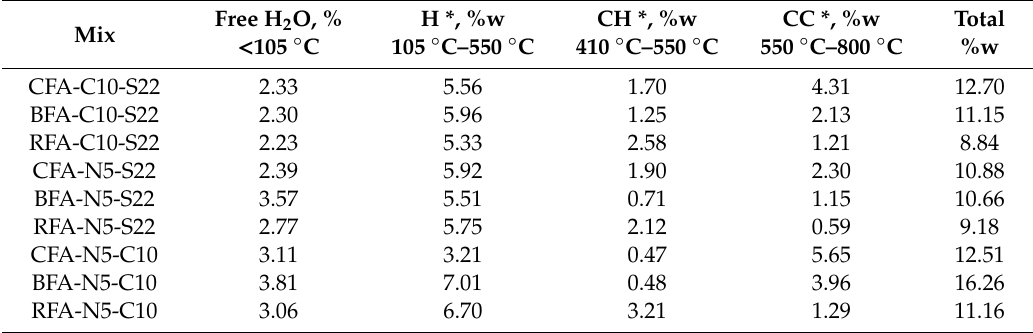
Table 3. The free water, the bound water of the hydrate phases, the Ca(OH) 2 , and the CaCO 3 content in